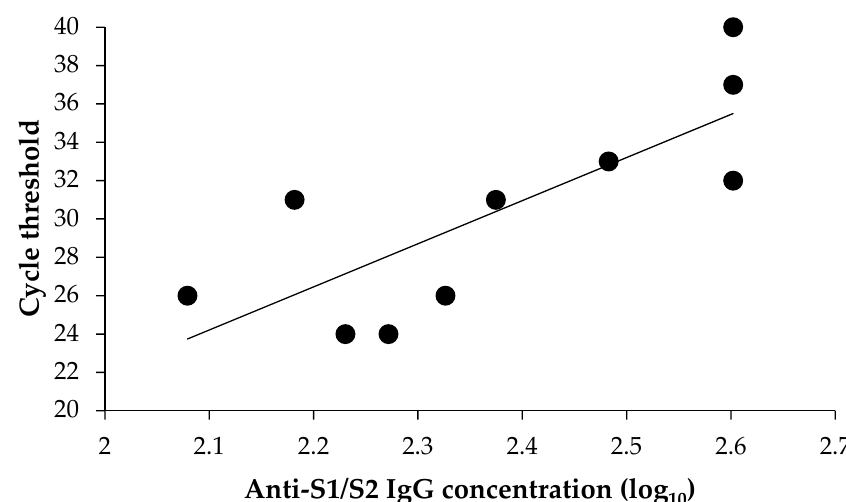
Figure 2. Association between anti-S1/S2 IgG concentration and viral load.